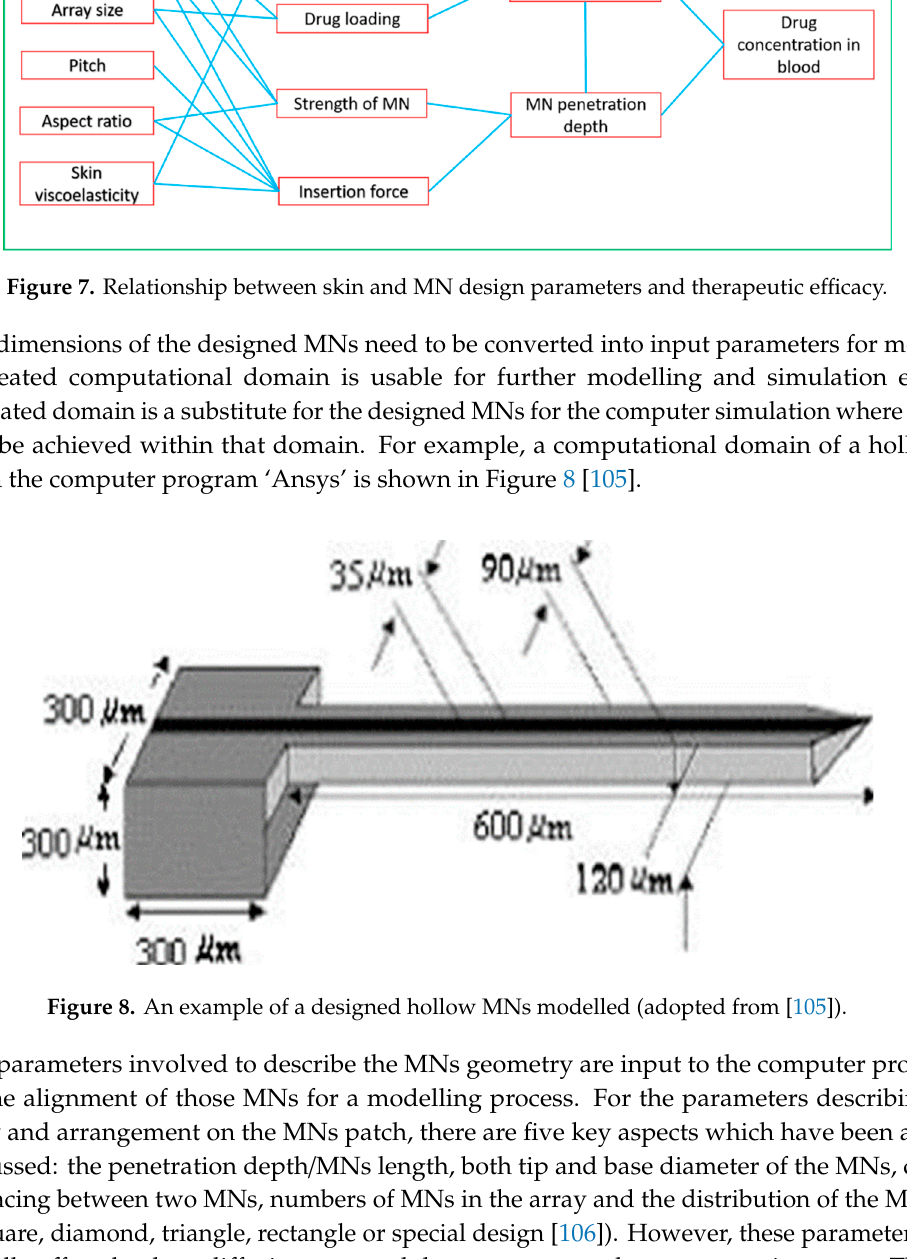
Figure 8. An example of a designed hollow MNs modelled (adopted from [105]).